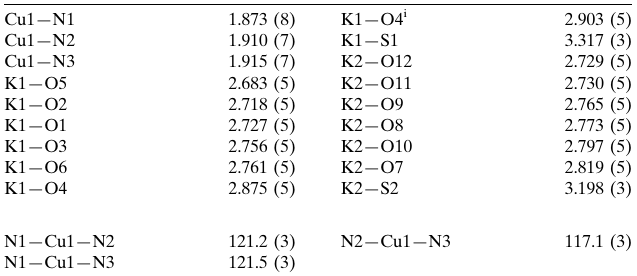
Selected geometric parameters (A˚ , (cid:2)